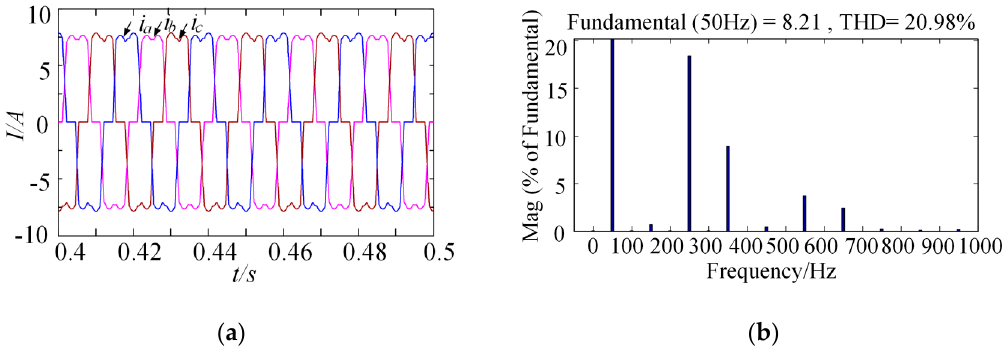
Figure 12. Before compensation: ( a ) Grid current; ( b ) Current THD.